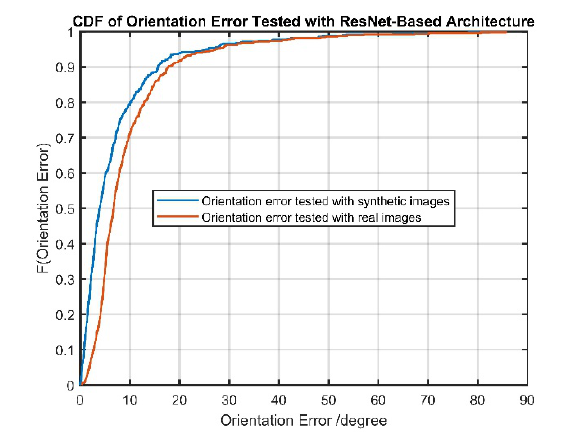
Figure 9. CDF of positioning errors tested with the ResNet- based CNN regression network